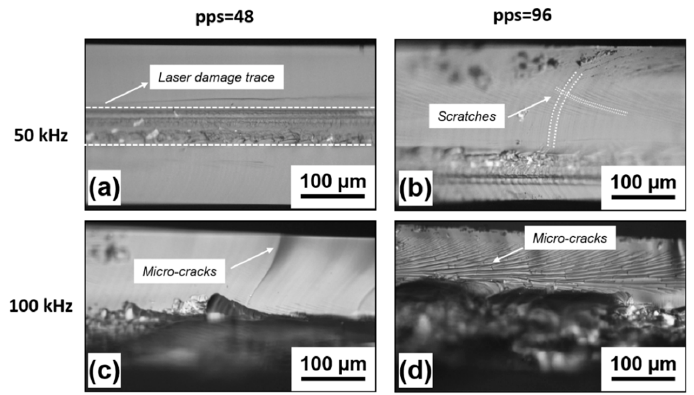
Figure 2. Optical microscope images of the cut edges obtained with a fixed pulse energy E p = 20 µ J and different repetition rates of 50 kHz and 100 kHz and pulse overlap pps= 48 and 96 ( a – d ).